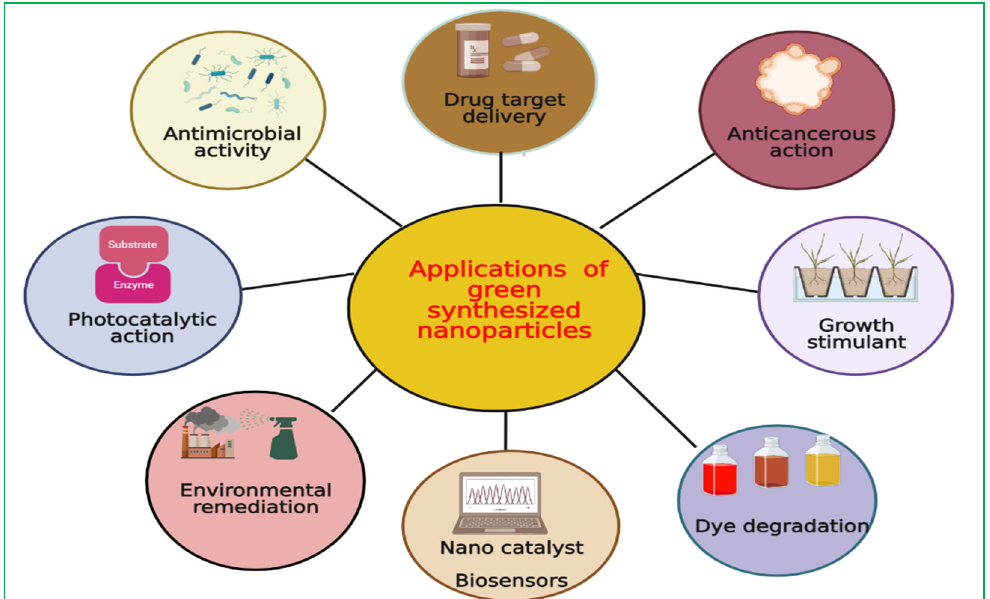
Figure 5. Applications of green synthesized nanoparticles in different fields. Black straight line represents the different applications of plant-synthesized nanoparticles in various fields of plant science and research-oriented